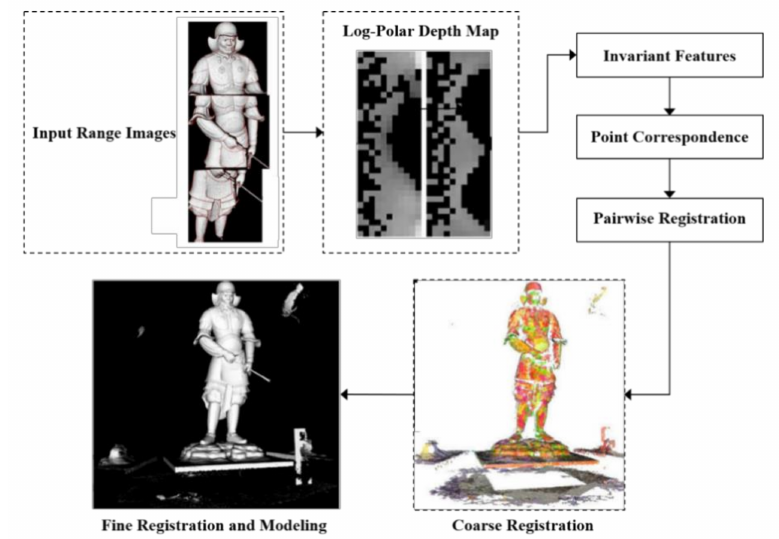
Figure 7. Overview of the registration method based on